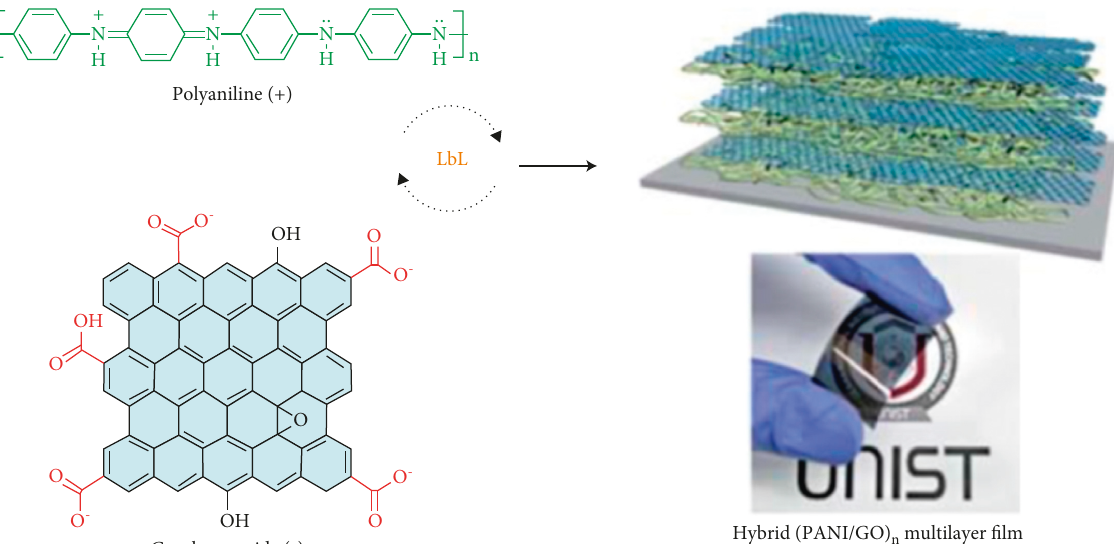
Figure 10: Polyaniline with graphene oxide using layer by layer of multilayer flexible film.